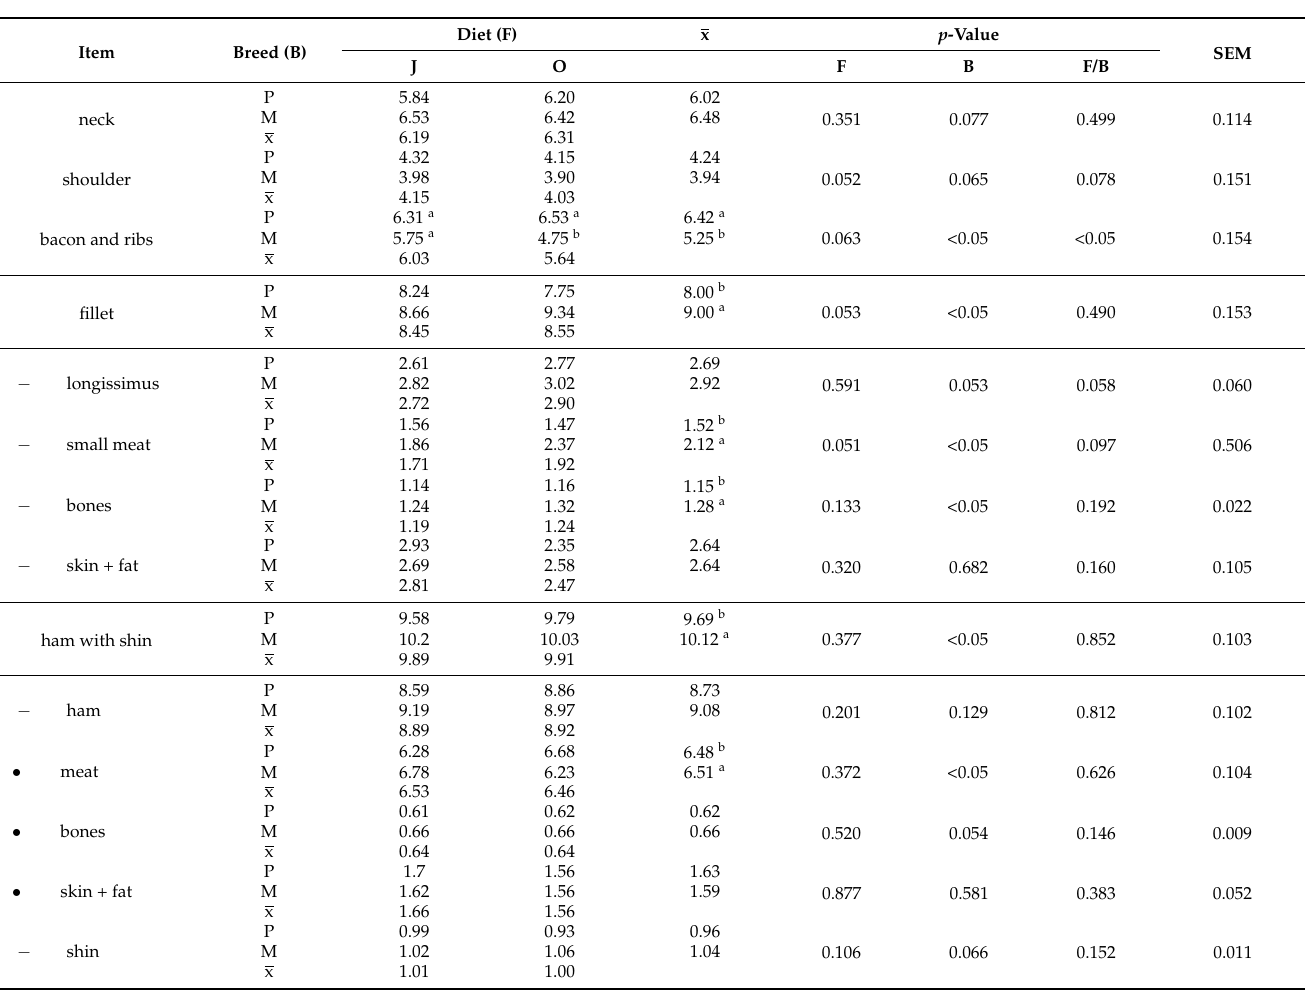
Table 4. Primal cuts weight (kg) of right